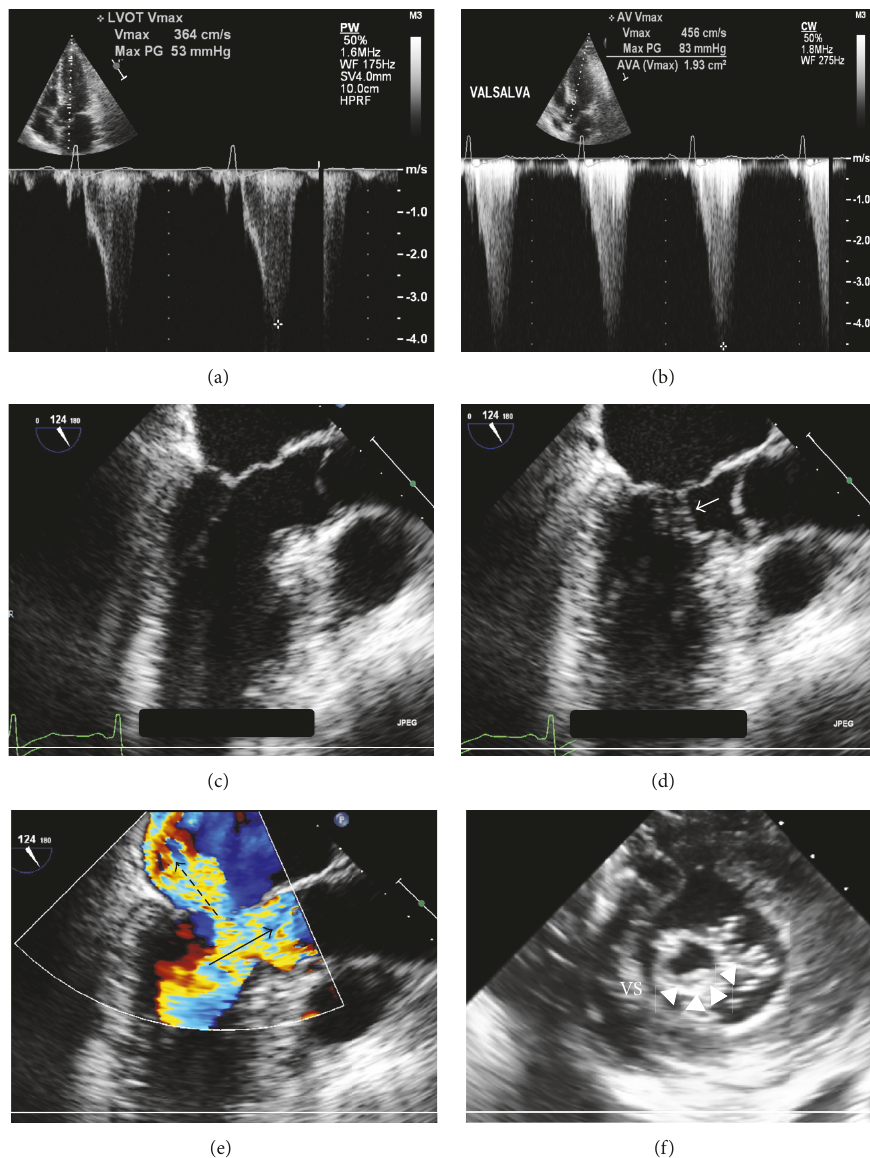
Figure 1: Transthoracic and transesophageal echocardiographic findings. (a) Pulse-wave Doppler at the LVOT showing a peak velocity of 3.94 m/s and gradient 62mmHg. The waveform contour is dagger-shaped. (b) Strain-phase Valsalva results in an increase in peak velocity to 4.56 m/s with gradient 83 mmHg. (c) Apical view at end-diastole showing no significant LVOT narrowing. The septal wall shows moderately increased thickness measured at 1.4cm. (d) Apical view during systolic phase showing mitral-septal contact (white arrow) consistent with SAM. (e) Color Doppler showing severe, posteriorly directed mitral regurgitation (dashed arrow) into a moderately enlarged left atrial cavity and significant turbulence across the LVOT (solid arrow). (f) Transgastric short-axis view at the level of the mitral valve during systolic phase, showing a large echodensity attached to lateral scallop of the anterior mitral leaflet